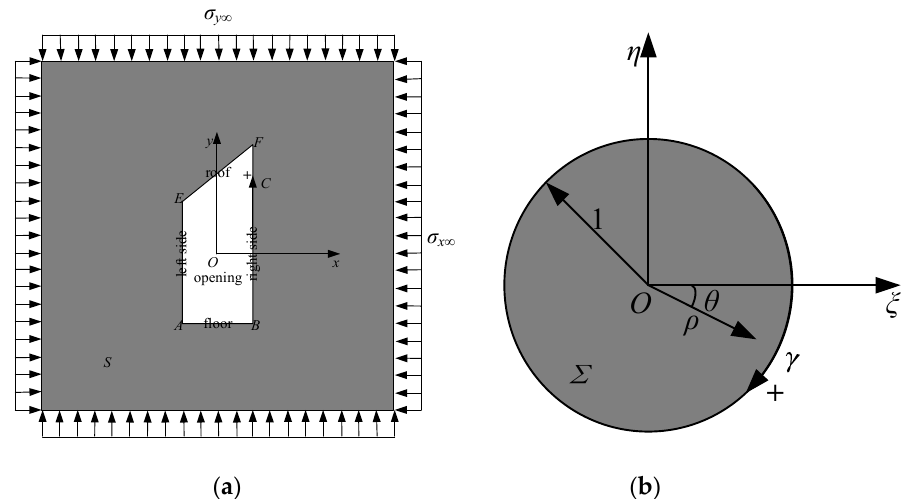
Figure 3. ( a ) Schematic diagram of the opening and system of coordinates; ( b ) unit circle and system of